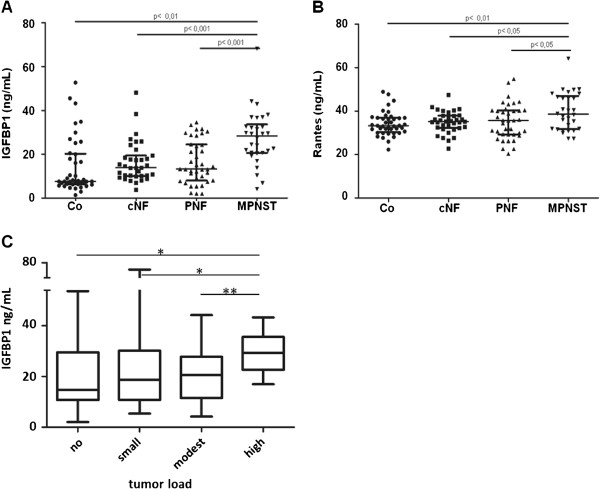
Quantitative protein array results of sera from 41 healthy controls and 104 patients with neurofibromatosis type 1 (NF1) subdivided into three groups. These comprised 35 patients with NF1 with no plexiform neurofibromas (PNF) and no malignant peripheral nerve-sheath tumors (MPNST) (cutaneous neurofibromas; cNF), 39 patients with NF1 with PNF and no MPNST, and 30 patients with NF1 with MPNST. (A) Insulin-like growth factor binding protein (IGFBP)1 and (B) Regulated upon activation, normal T-cell expressed and secreted (RANTES). (C) IGFBP1 serum concentrations in patients with NF1 with different internal tumor loads as measured by MRI-based volumetry (0 cm3 = no load, 1 to 99 cm3 = small load; 100 to 500 cm3 = modest load; >500 cm3 = high load). Statistical analysis was performed using the non-parametric Mann–Whitney U-test, including Bonferroni correction (*P≤0.05; **P≤0.01; ***P≤0.001).